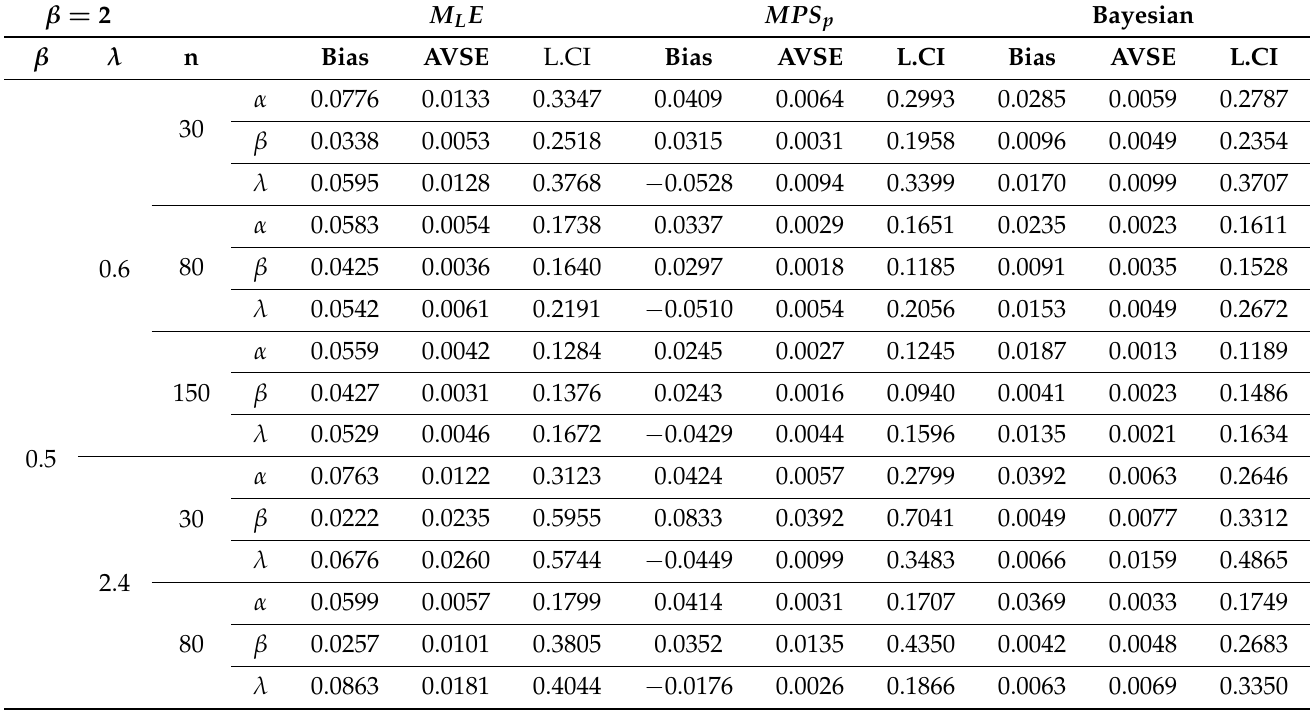
Table 17. M L E , MPS p and Bayesian estimation methods for parameters of UEPD when β =